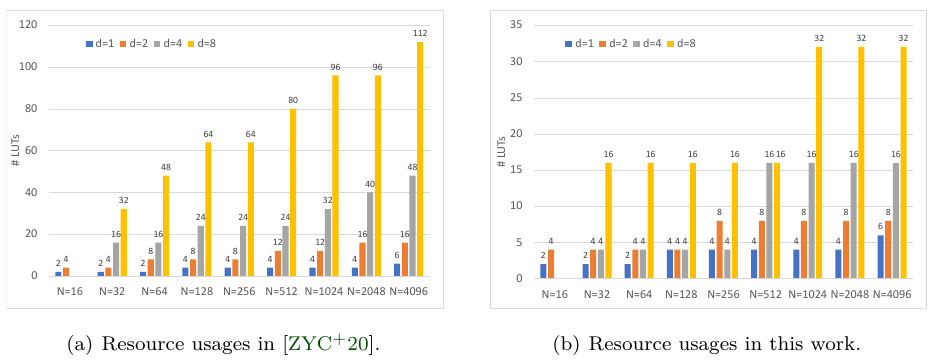
Figure 13: The comparison of radix-2 mapping scheme between [ZYC + 20] and this